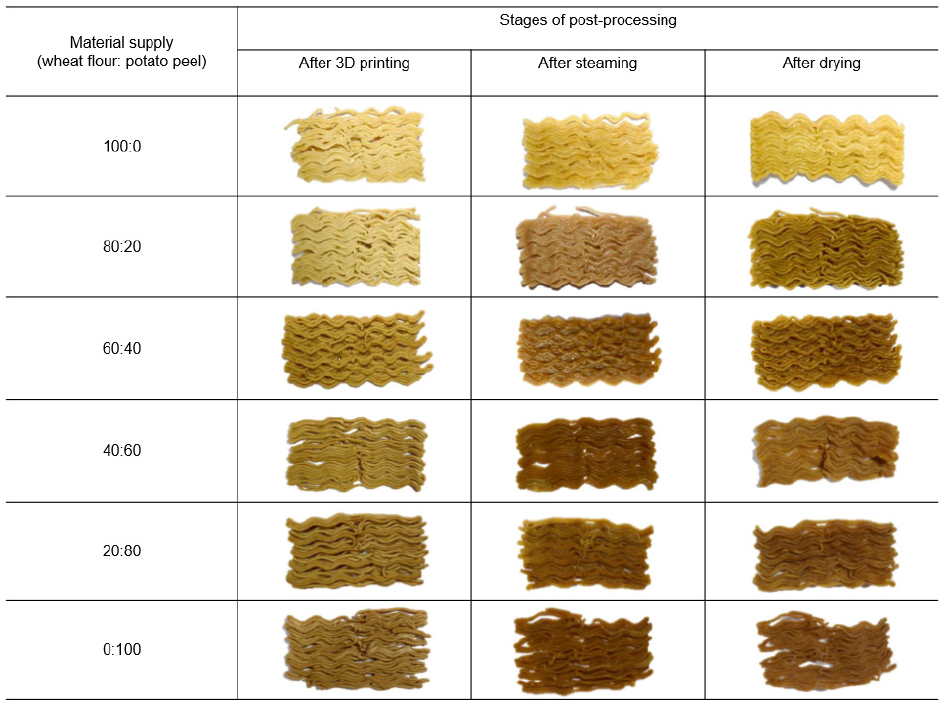
Figure 4. Optimization of material supply for 3D-printed noodles from potato peel waste “Re- printed/adapted with permission from Ref. [7]. Copyright © 2021, exclusive license to Springer